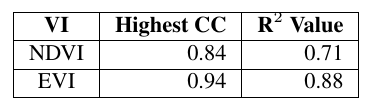
Table 6: Regression analysis results of highest correlated cumu- lative mean VI with yield